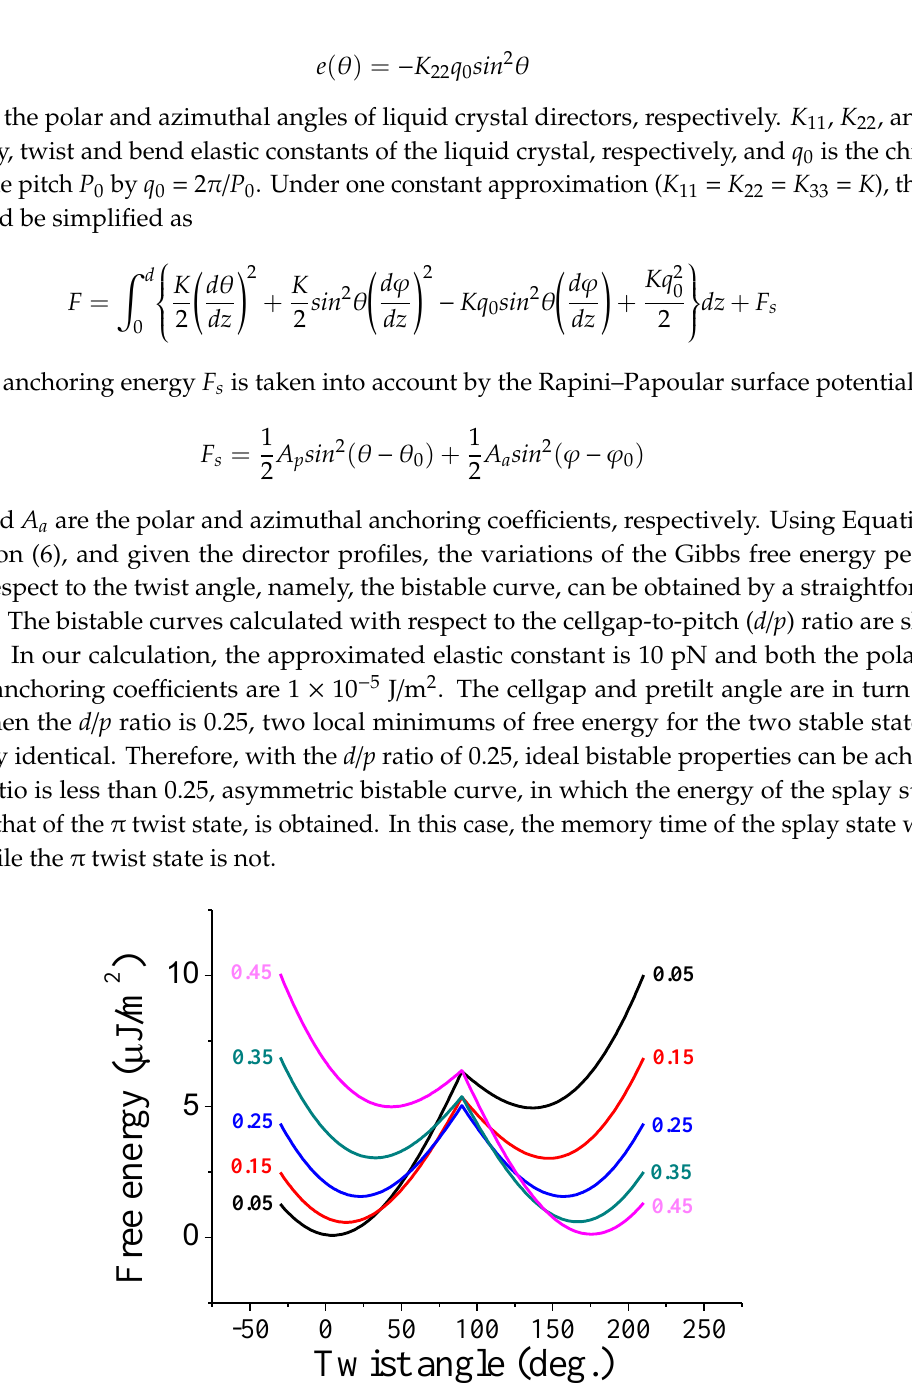
Figure 2. Bistable curves with respect to the different d / p ratios. The approximated elastic constant is 10 pN and both the polar and azimuthal anchoring coefficients are 1 × 10 −5 J/m 2 . The cellgap and pretilt angle are in turn 6 μm and 5°.